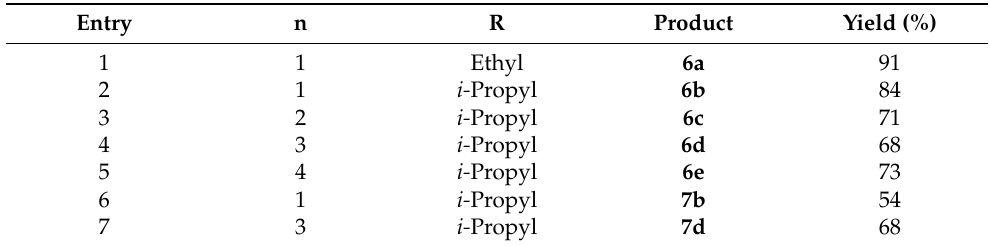
Table 4. Obtained yields of 2,5-dialkyl-1,3,4-oxadiazole ( 6a – e ) and products of their hydrolysis containing carboxylic groups ( 7b , 7d ).